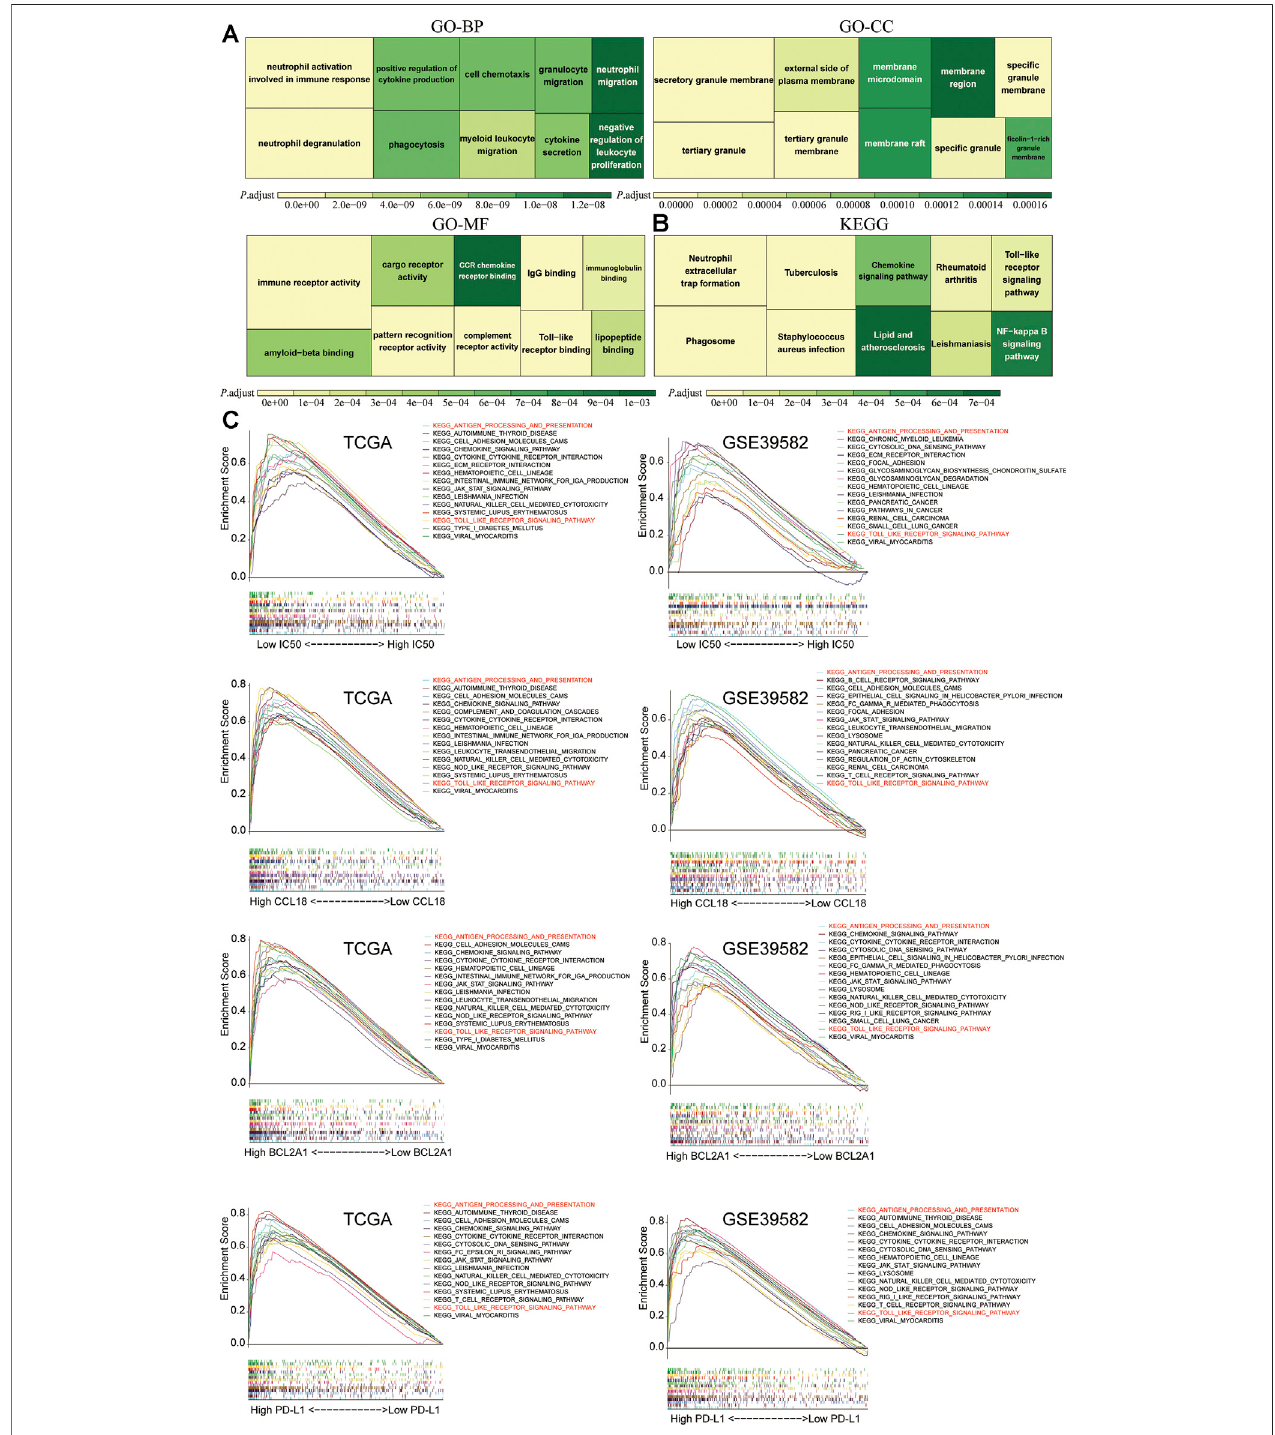
FIGURE 13 | The functional enrichment analysis and GSEA. The (A) GO and (B) KEGG analysis of 80 genes signi fi cantly related to CCL18 and BCL2A1 (Spearman ’ s correlation coef fi cient > 0.6) in TCGA and GSE39582. (C) In TCGA and GSE39582, between the high and low groups of IC50, CCL18, BCL2A1, and PD- L1, among 186 KEGG pathways, there were two shared signi fi cant enrichment pathways, which are marked in red.